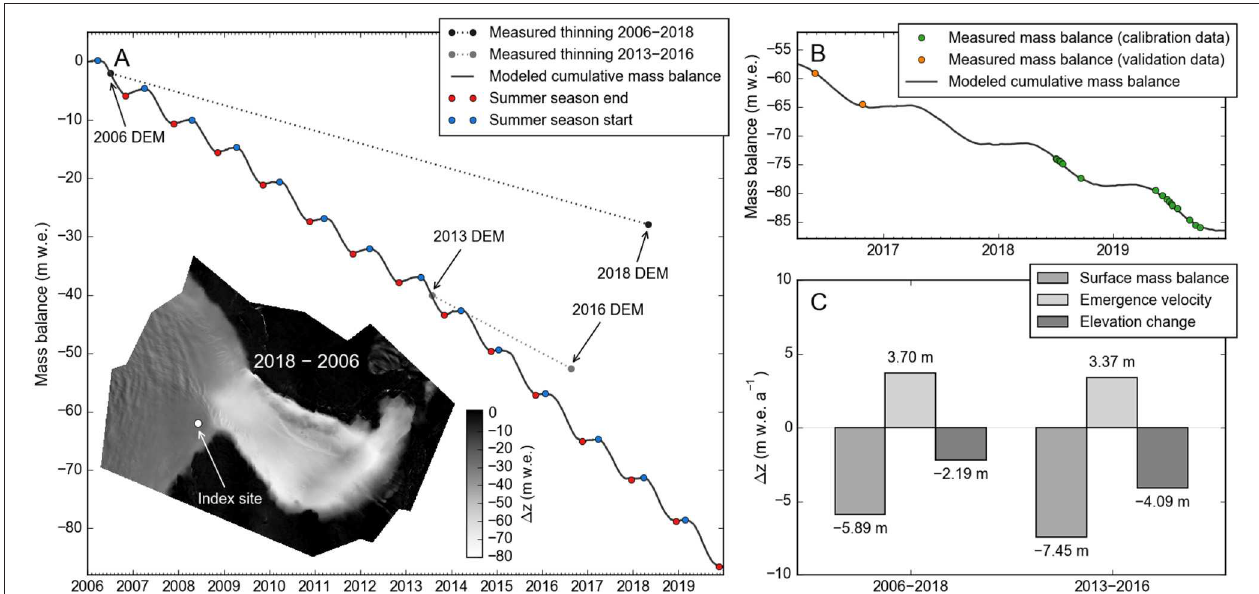
FIGURE 6 | (A) Cumulative mass balance modeled for the index site outside Suicide Basin, period January 2006–December 2019. Colored dots denote annual maxima and minima in the mass balance series, which mark the start and end of the summer and winter seasons in the stratigraphic time system. The dotted lines show the glacier thinning in m w.e. obtained from differencing two DEM pairs (2006–2018 and 2013–2016, Figure 5 ). The inset map in (A) shows the ice thinning across the basin and the basin entrance derived from differencing the July 2006 and April 2018 DEMs. The map also shows the location of the mass balance index site. (B) The same cumulative mass balance series as in (A) , but shown only for the 2016–2019 period, for which mass balance calibration and validation data was collected at the index site. (C) Annual surface mass balances, emergence velocities, and elevation changes for the two sub-periods with DEM availability. The emergence velocities are the difference between the modeled surface mass balance and the DEM-derived elevation changes in m